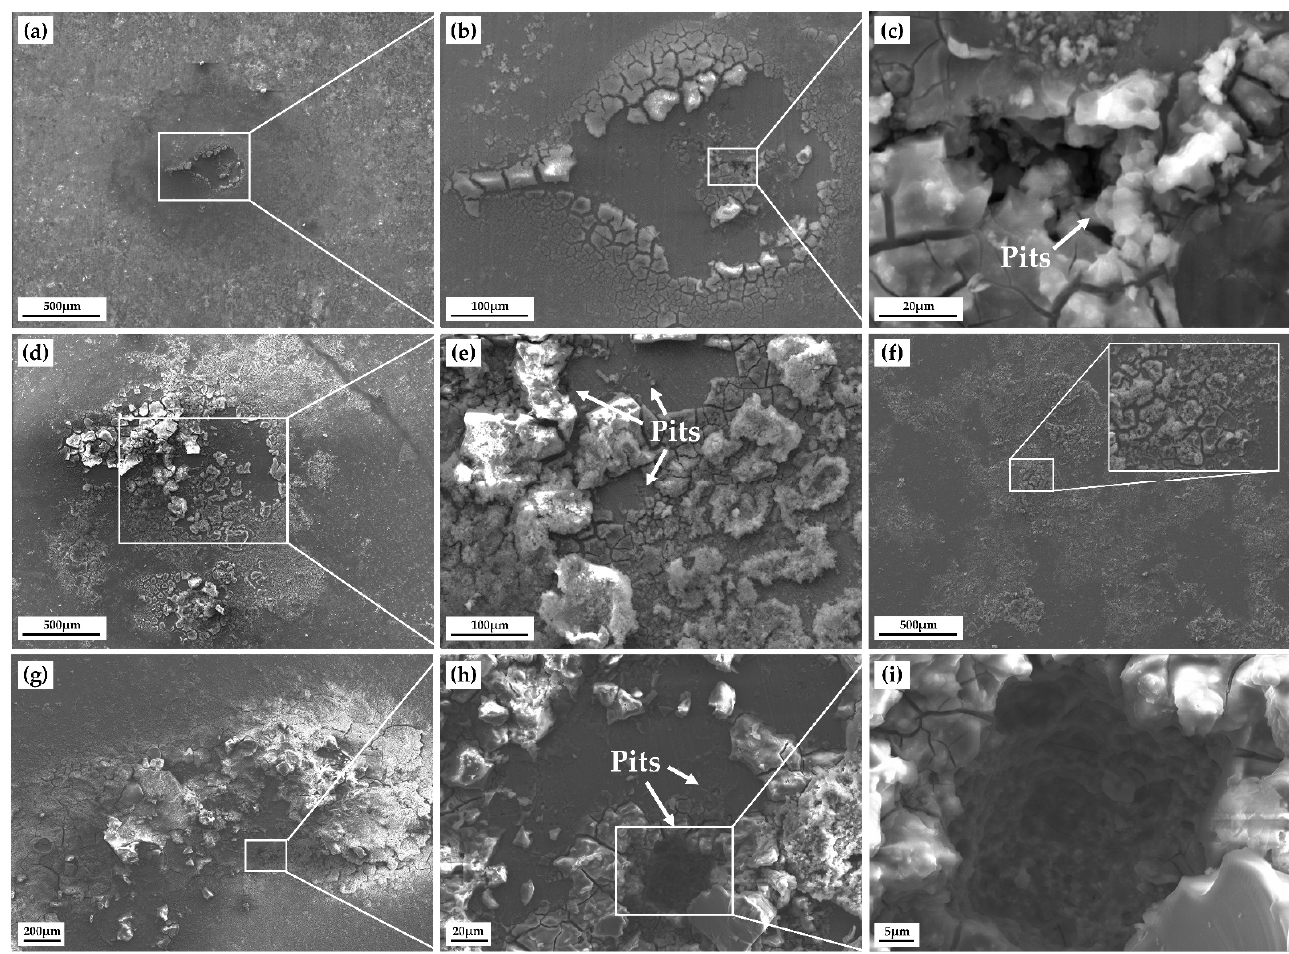
Figure 4. Surface microscopic morphology of the 7B04-T74 aluminum alloy after alternate immersion test for ( a ) 48 h, ( d ) 96 h, ( f ) 144 h, and ( g ) 576 h, where ( b , c , e , h , i ) are enlarged images of ( a , d , g ),